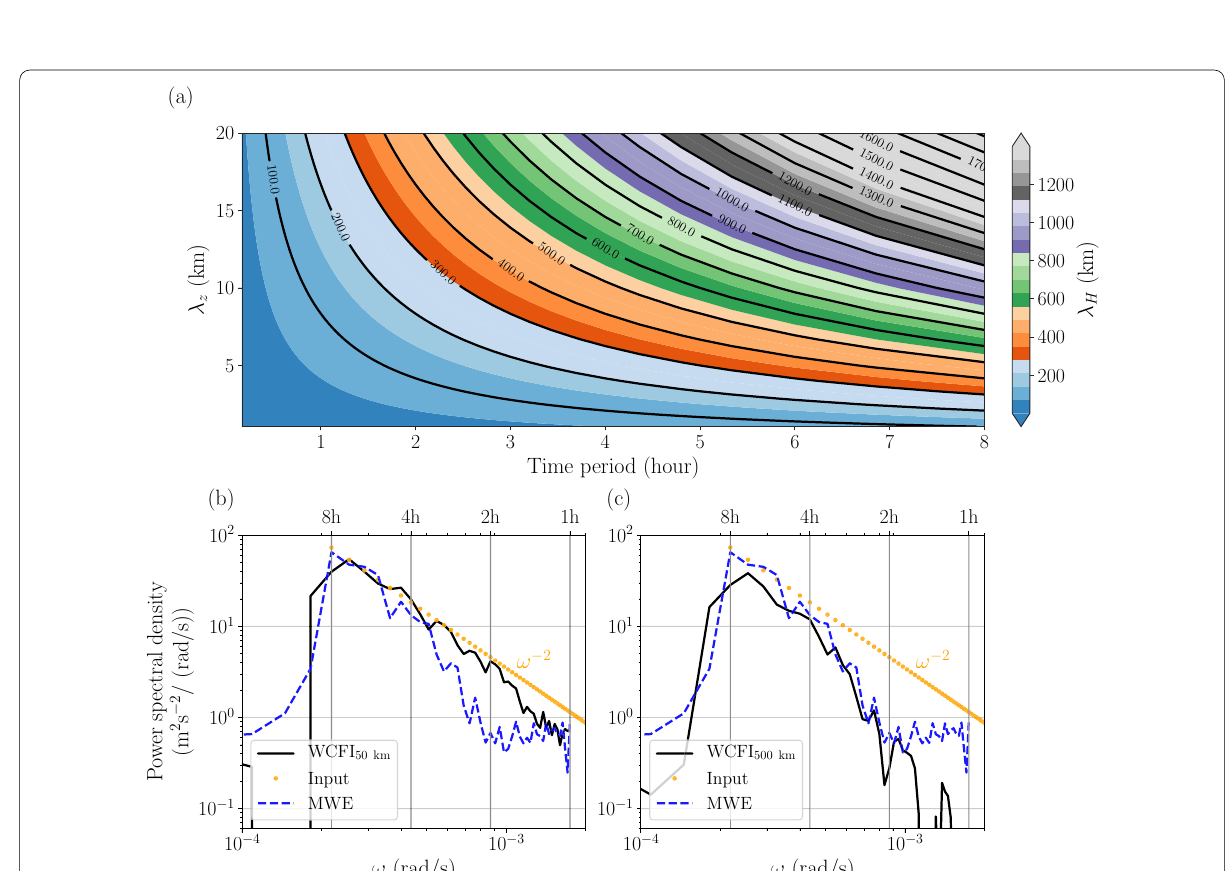
Fig. 4 a Contour plot shows the dependence of horizontal wavelength (cid:31) h with time-period ( T ) and vertical wavelengths ( (cid:31) z ) of the simulated monochromatic GWs. b Orange dotted line shows the input frequency spectra with a power-law slope of illustrate the spectra estimated by the WCFI with 50 km horizontal resolution and MWE method, respectively, using the GW model simulation. c Black line plot shows the WCFI spectra estimated with 500 km horizontal resolution. The blue and orange plots are identical to plot ( b ), which are added for